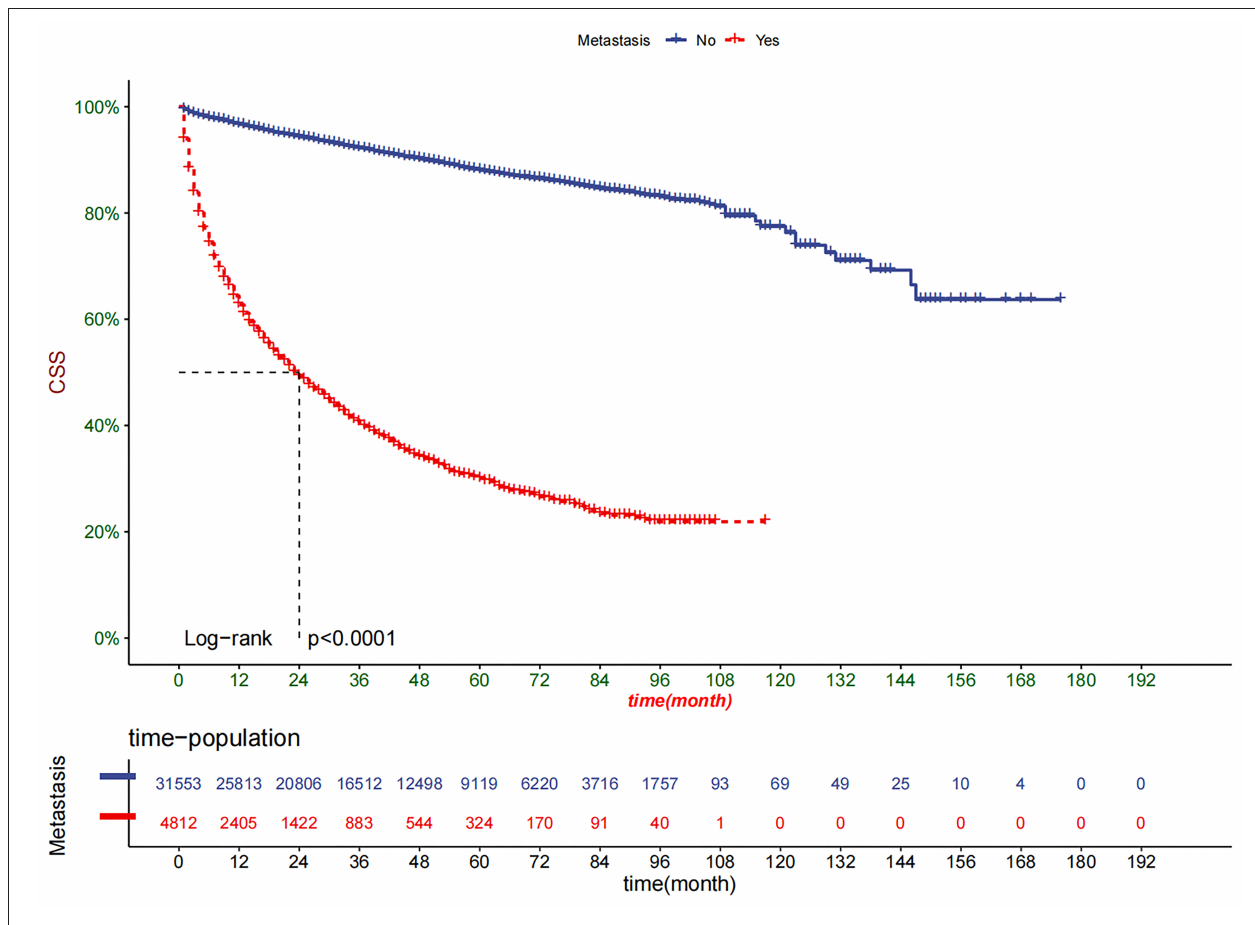
FIGURE 6 | Kaplan–Meier curves of CSS for patients in the low-risk and high-risk groups.